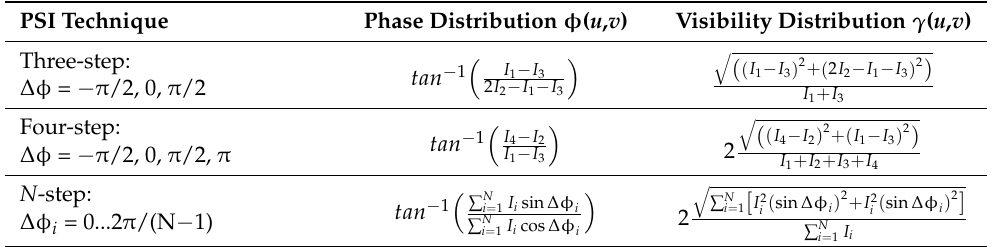
Table 1. Three-, four-, and N -step PSI